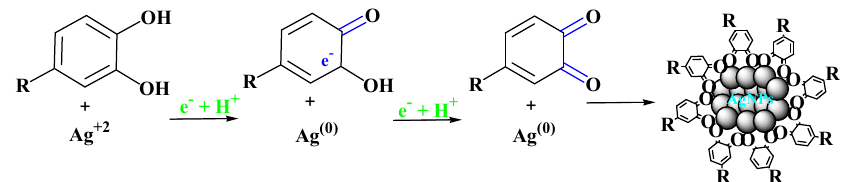
Scheme 1: A plausible mechanism for synthesis of AgNPs by plant